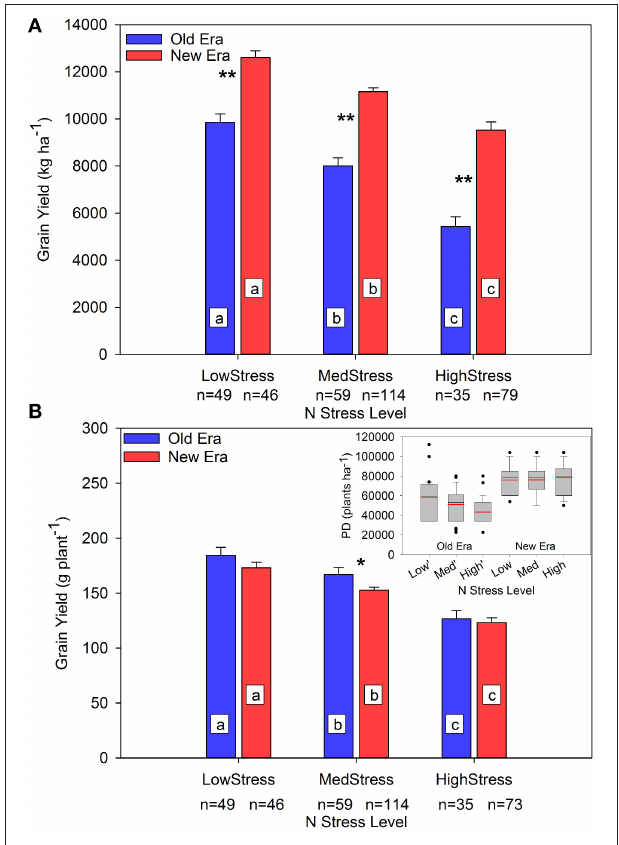
FIGURE 3 | Relationship between N stress level and grain yield (kg ha − 1 ) (A) and grain yield (g plant − 1 ) (B) across maize genotypes in the Old and New Eras as determined by R1 NNI. Different letters signify LSMeans within Eras (Old or New) are significantly different across N stress levels. An * denotes a significant difference between the Old and New Era LSMeans within a given N stress level. * denotes significance at the 0.05 probability level. ** denotes significance at the 0.01 probability level. The sub-figure in panel (B) represents the distribution of plant density (PD) within each group. Black lines represent the group median PD and red lines represent the group mean